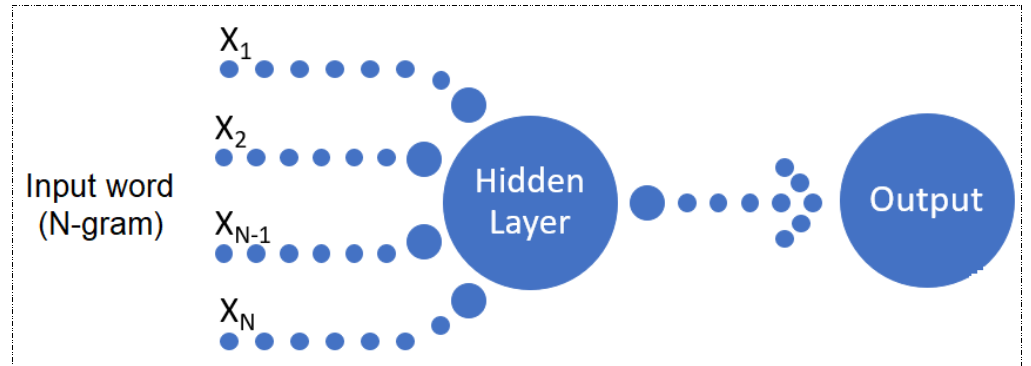
Figure 3. FastText architecture.